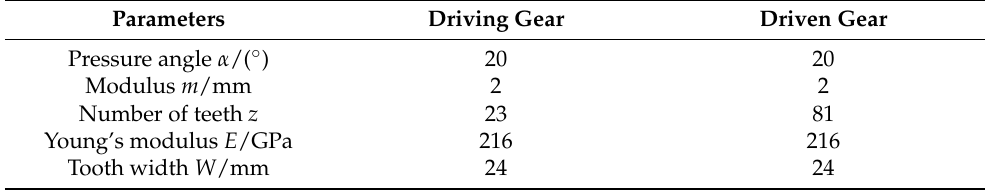
Table 2. Main parameters of the gear pairs.